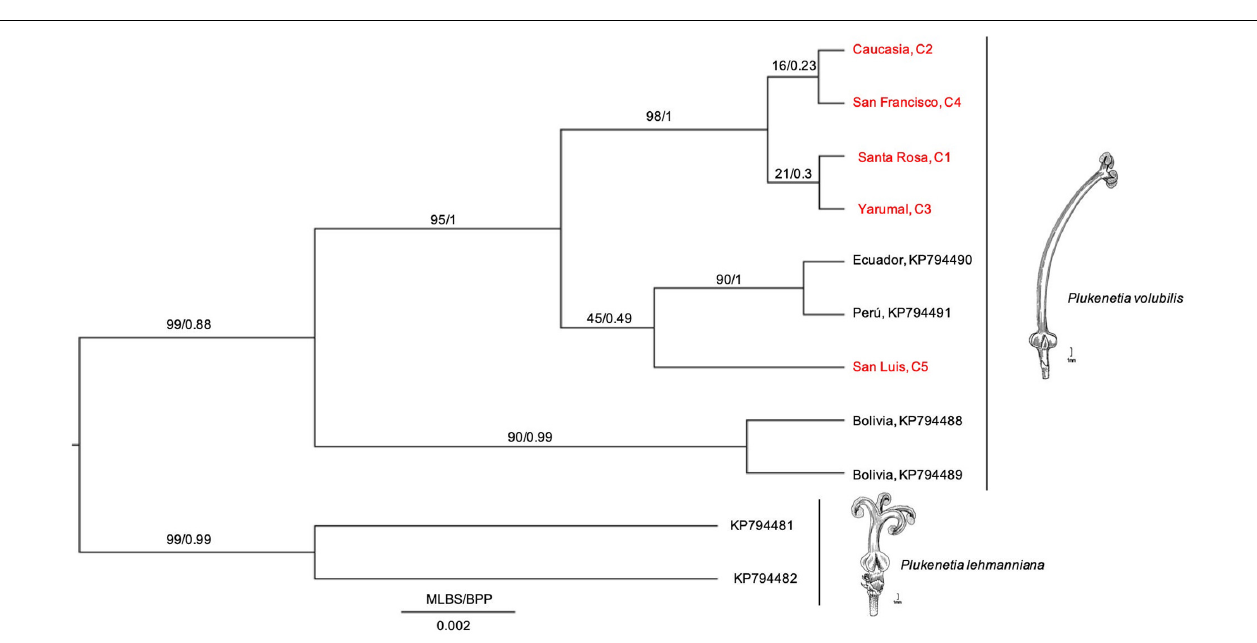
FIGURE 3 | Phylogenetic hypothesis based on psbA-trnH GUG IS of the P. volubilis cultivars from Antioquia, Colombia, its relatives (KP794488-89 from Bolivia, KP794491 from Perú, and KP794490 from Ecuador, see Cardinal-McTeague and Gillespie, 2016) and selected outgroups (KP794481-82 representing P. lehmanniana ). Phylogenetics methods were listed in Section “Materials and Methods.” Illustrations from Cathy Pasquale were adapted from Gillespie